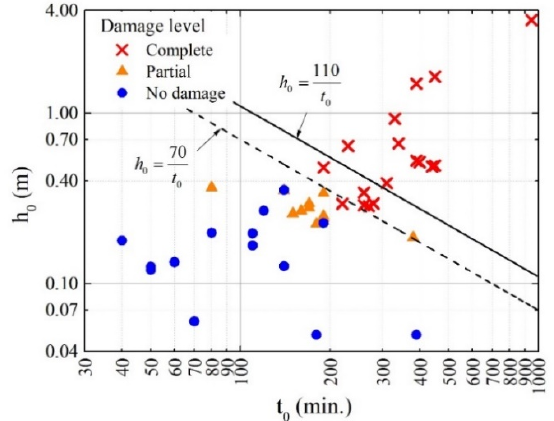
Figure 17. Simulated results of the overflow depth ( ℎ (cid:2868) ) and overflow duration ( 𝑡 (cid:2868) ) at the damage locations